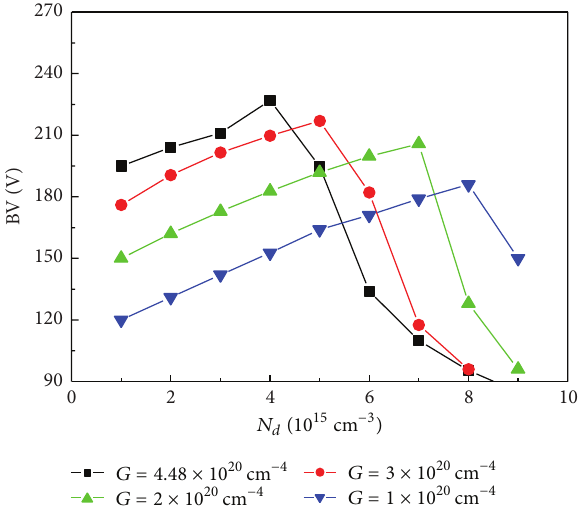
Figure 6: Dependences of BV on 𝑁 𝑑 with 𝑡